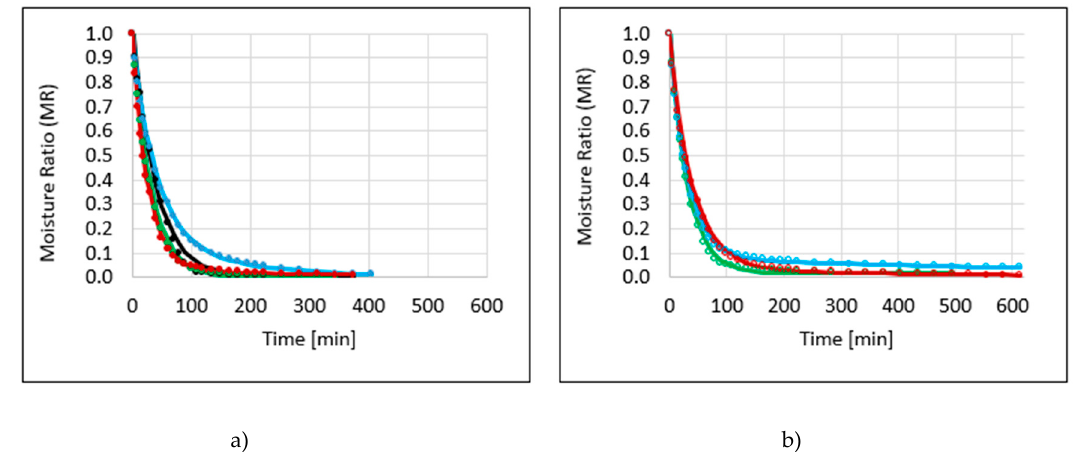
Figure 1. Drying kinetics of apple samples by the convective method (CD), previously osmo-dehydrated in erythritol (blue line), xylitol (green line), sucrose (red line), and without osmotic dehydration (OD) (black line), without application of ultrasound ( a ) or with ultrasound (US) pre-treatment ( b ). Parameters of drying models and statistical values of root-mean-square error (RMSE) and R 2 are presented in Table 1.